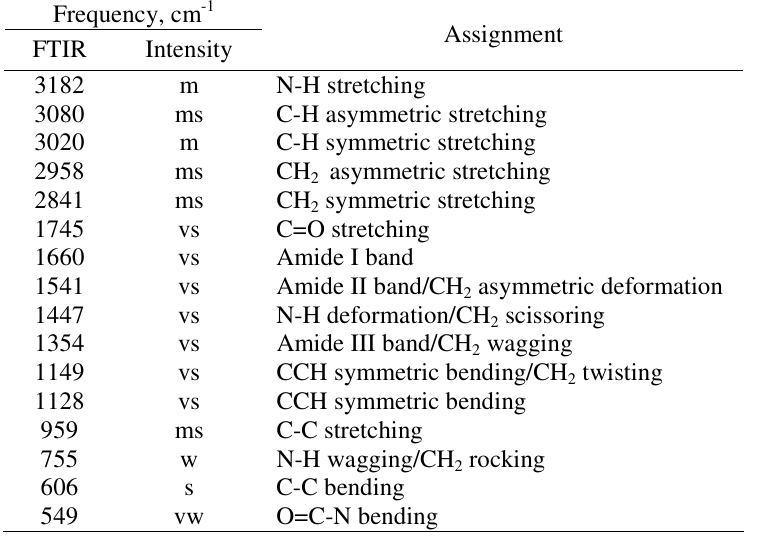
Table 1. FTIR spectra and assignment of nylon-66